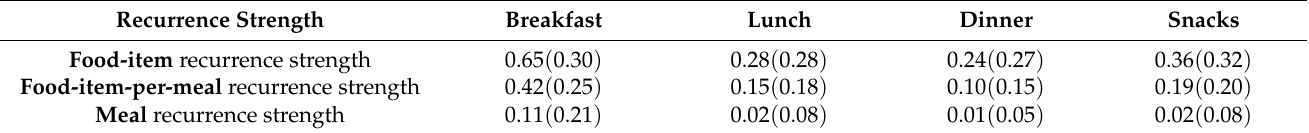
Table 8. The mean (standard deviation) statistics of recurrence strength measures across meal occasions.